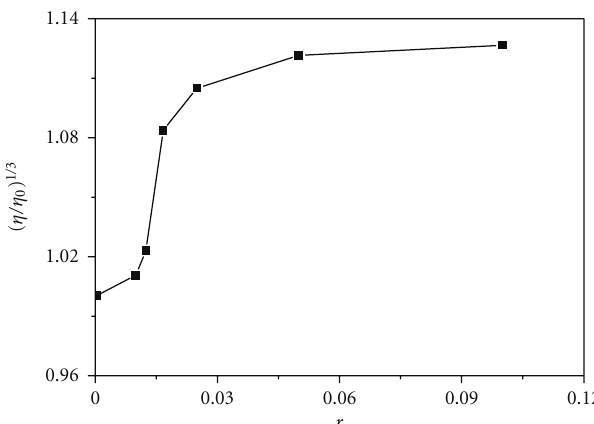
Figure 5: E ff ect of increasing amounts of complex 1 (0–100 μ M) on the relative viscosity of CT-DNA (100 μ